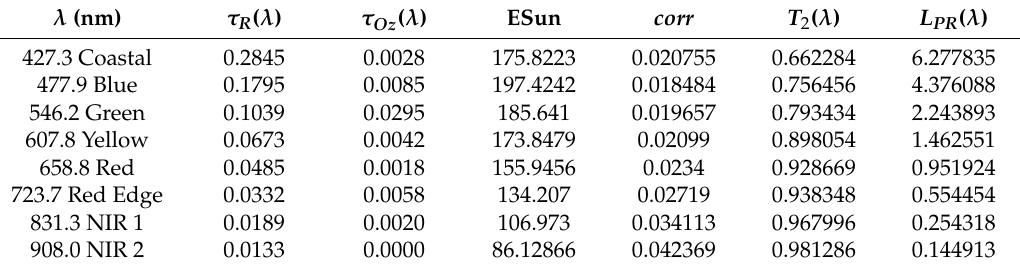
Table 1. Coefficients for atmospheric correction of the WorldView-2 scene ( τ R ( λ ) is the Rayleigh optical thickness. τ Oz ( λ ) is the Ozone optical thickness. ESun is the WorldView-2 band-averaged solar spectral irradiance ( µ Wcm − 2 nm − 1 ). T 2 ( λ ) is the atmospheric diffuse transmission coefficient. L PR ( λ ) is the Rayleigh path radiance ( µ Wcm − 2 nm − 1 ). Corr is the correct coefficient integrating earth-sun distance, in-band solar irradiance, solar zenith angle and π